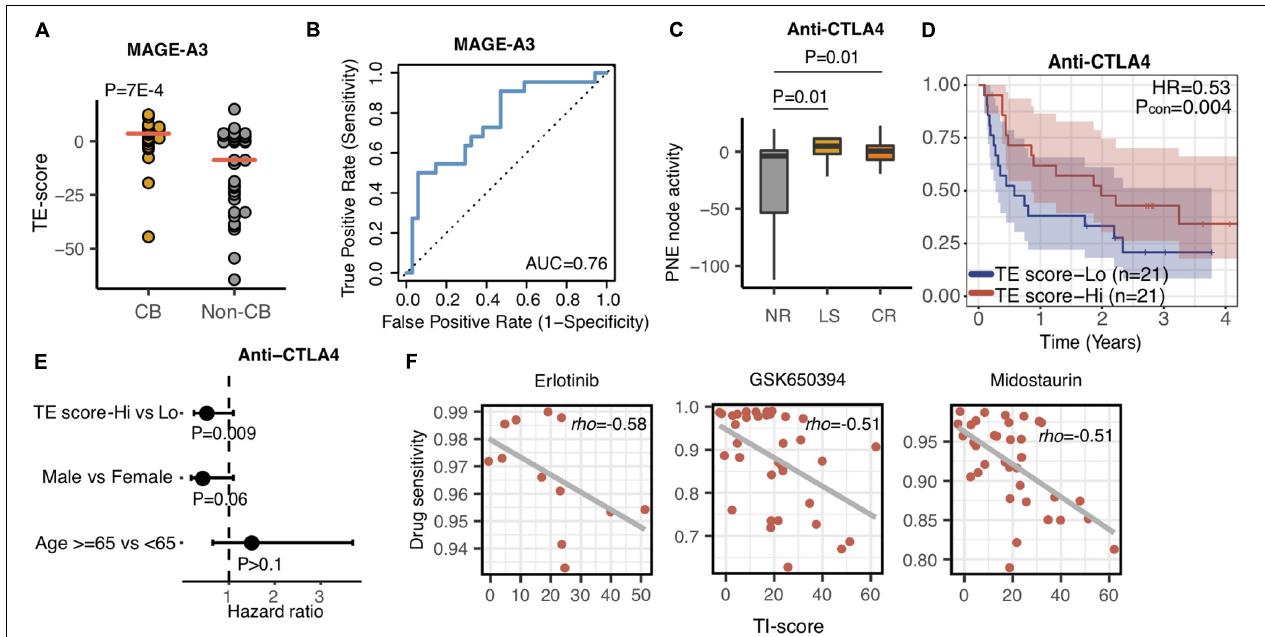
FIGURE 6 | The TE and TI signatures are predictive of drug response. (A) Dot plot indicating the TE-signature score difference between responder and non-responder. P -value was calculated by Wilcoxon rank-sum test. (B) Receiver operating characteristic (ROC) curves for MAGE-A3 therapy response prediction in melanoma patients using the TE-signature score as the predictor. (C) Boxplot depicting the TE-signature score difference between different response groups treated with Anti-CTLA4 therapy. P -value was calculated by Wilcoxon rank-sum test. (D) Kaplan–Meier plots depicting the survival distribution for patients with high (red) and low (blue) TE-signature scores. In Kaplan–Meier plots, p -values were calculated using the log-rank test and vertical hash marks indicate censored data. (E) Forest plot showing hazard ratios and p -values of TE-signature scores and several clinical variables estimated by a multivariate Cox regression model. In all forest plots, HR was presented as the 95% confidence interval, the dotted lines indicate the null association, and the Wald’s test was used to determine statistical significance. (F) Scatterplot showing the correlation between TI-signature score and Erlotinib, GSK650394, or Midostaurin drug sensitivity. In all scatterplots, the rho was calculated by spearman